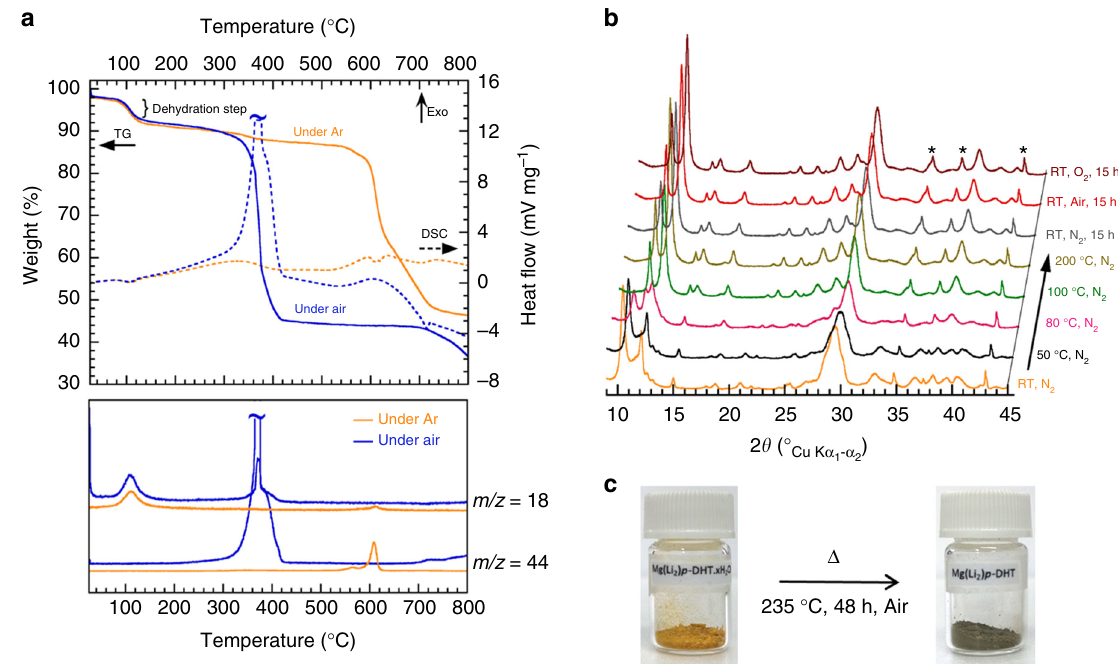
Fig. 2 Thermal properties of Mg(Li 2 )- p -DHT·H 2 O. a Thermogravimetry (TG) and differential scanning calorimetry (DSC) traces of Mg(Li 2 )- p -DHT·H 2 O measured under argon or air fl ow at a heating rate of 5 °C min − 1 , combined with mass spectrometry (MS) data; m/z = 18 is ascribed to H 2 O, and 44 to CO 2 evolutions, respectively. b TRXRPD patterns collected under nitrogen fl ow from RT to 200 °C. After an isotherm at 200 °C (16 h), the sample was cooled down to 20 °C and maintained under N 2 for 15 h before changing the atmosphere for air, and then fi nally for pure O 2 fl ow (* corresponds to the diffraction peak of the sample holder made of Al 2 O 3 ). c The orange color of the pristine powder changed to a khaki color after the dehydration process at 235 °C for 48 h in